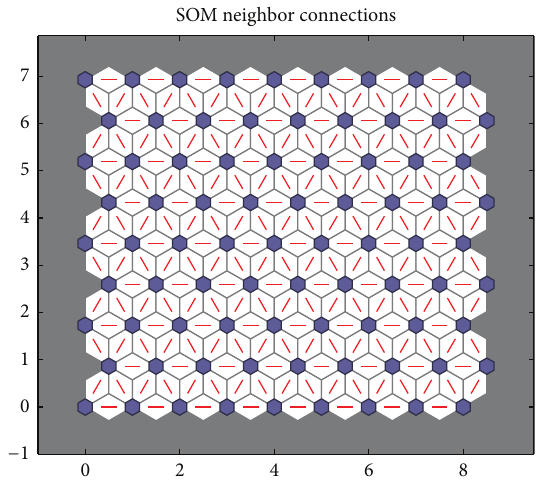
Figure 11: Topology structure of SOM neural